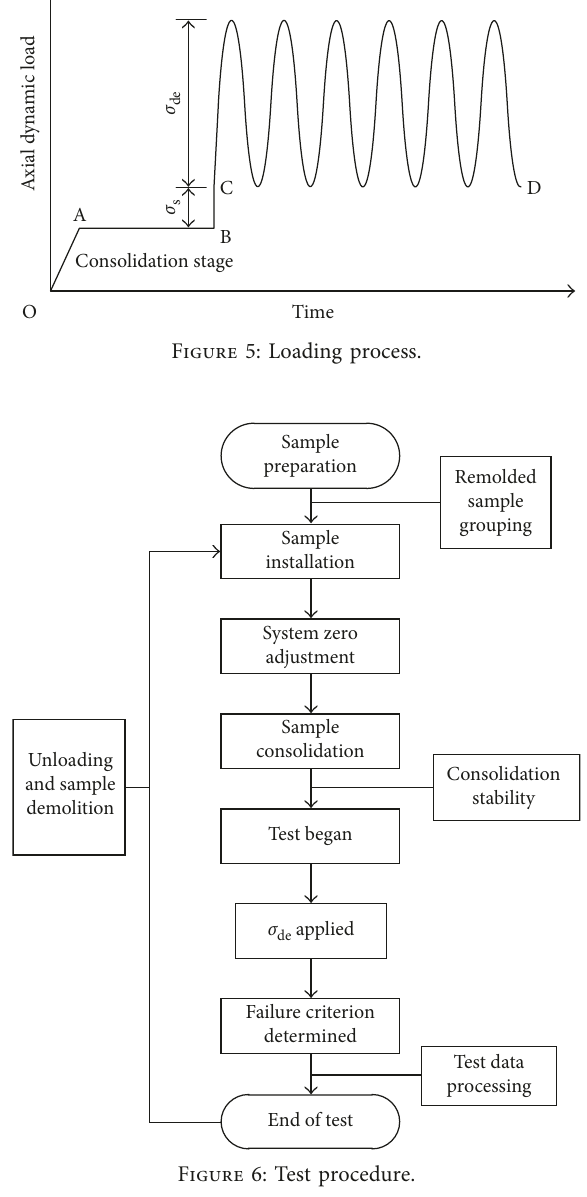
Figure 6: Test procedure.